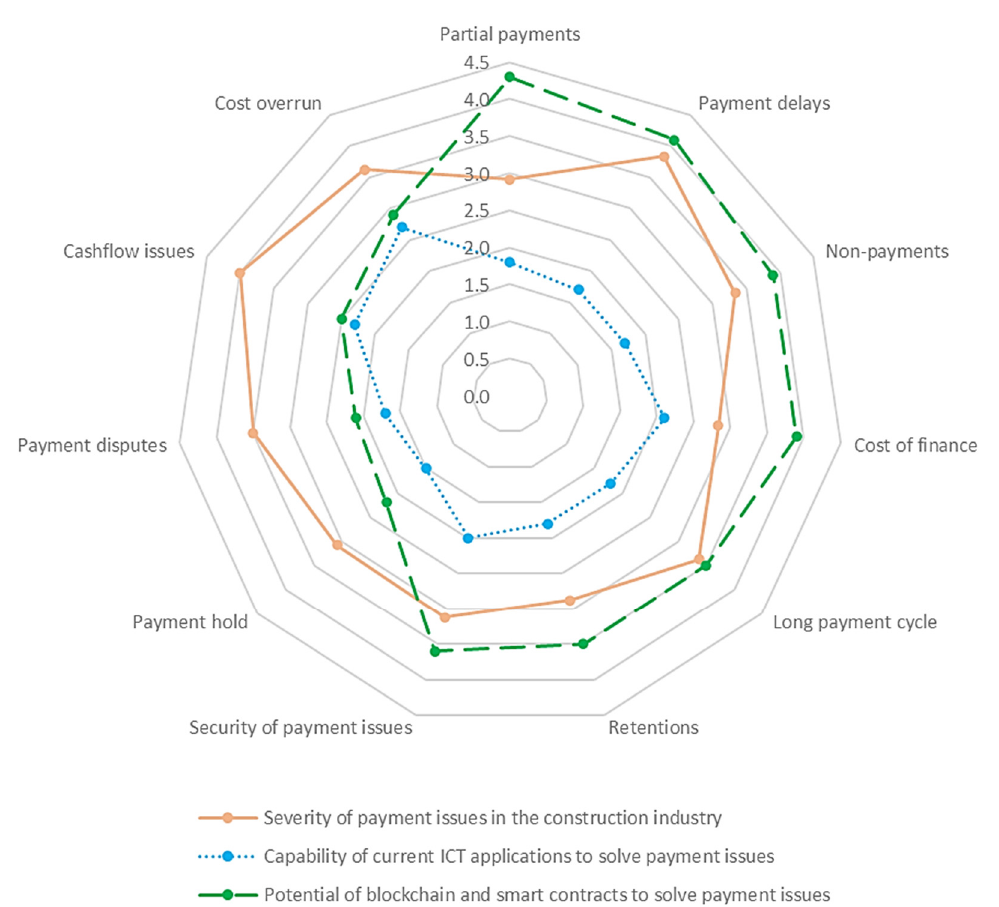
Figure 4. Mapping of the severity of payment issues, and capability of current ICT applications and potential of blockchain and smart contracts to solve payment issues.